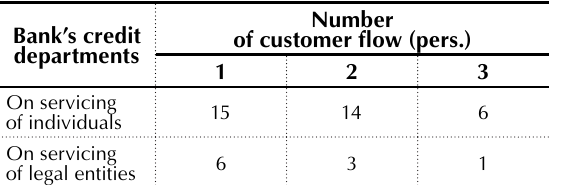
Table 4. Number of bank’s customers flow